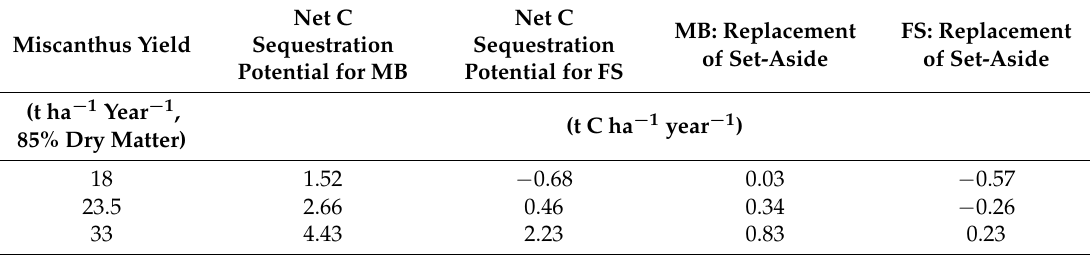
Table 4. Net carbon sequestration potential of Miscanthus briquettes for both present and future scenarios and the amount of carbon saved or lost by the replacement of set-aside land with Miscanthus